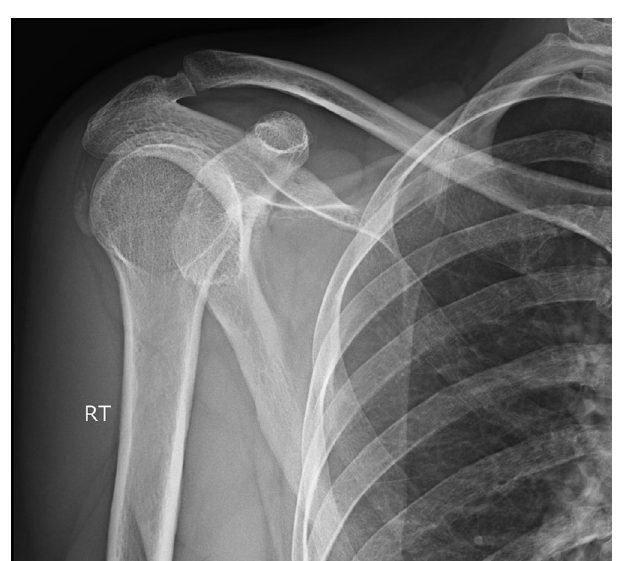
Figure 1. X-ray of a 41-year-old female patient who works as secretary, suffering from calci fi ed tendinopathy before the start of the treatment protocol. The calci fi c deposit lies on the insertion of